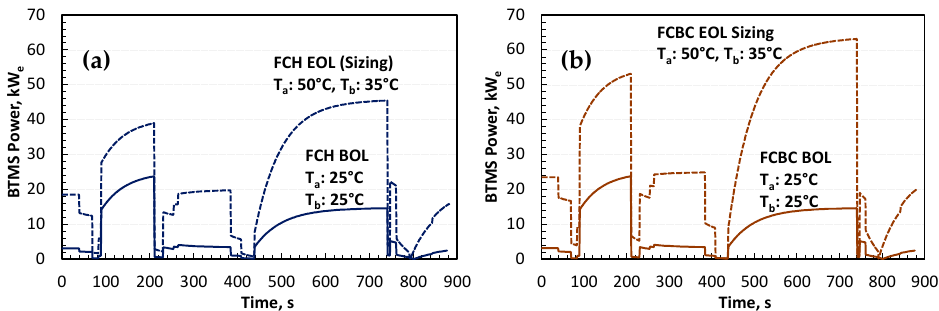
Figure 6. Dynamic BTMS power consumption on truck drive cycle at extreme conditions representing 100% and 70% battery state of health (BOL and EOL) and the hot and normal ambient temperatures (50 and 25 °C), which also affect the battery temperature (35 and 25 °C): ( a ) FCH platform; ( b ) FCBC platform